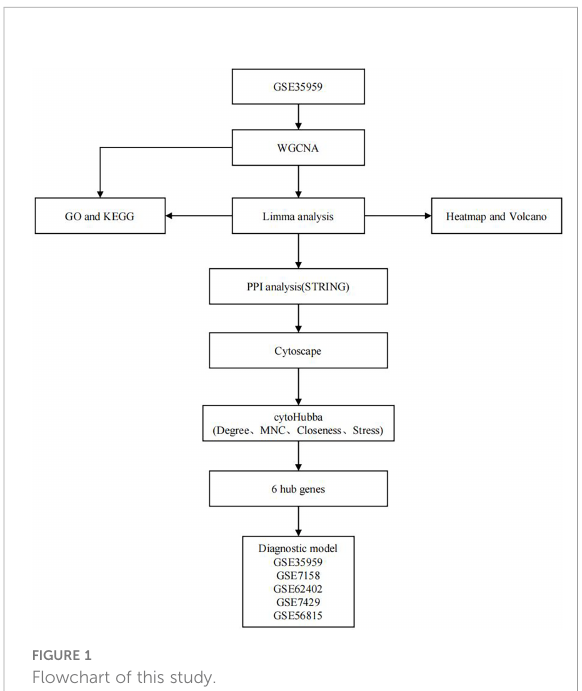
FIGURE 1 Flowchart of this